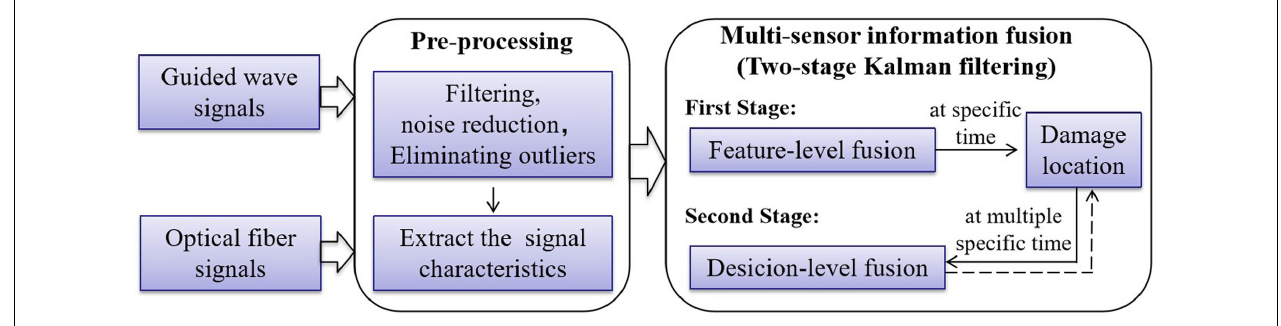
FIGURE 1 | The heterogeneous signal fusion process based on a piezoelectric-fiber hybrid sensor network.